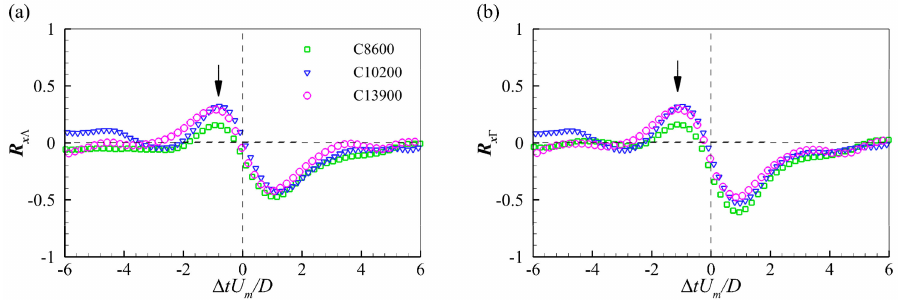
Figure 11. Correlation functions of ( a ) streamwise position and swirling strength, and ( b ) streamwise position and circulation.